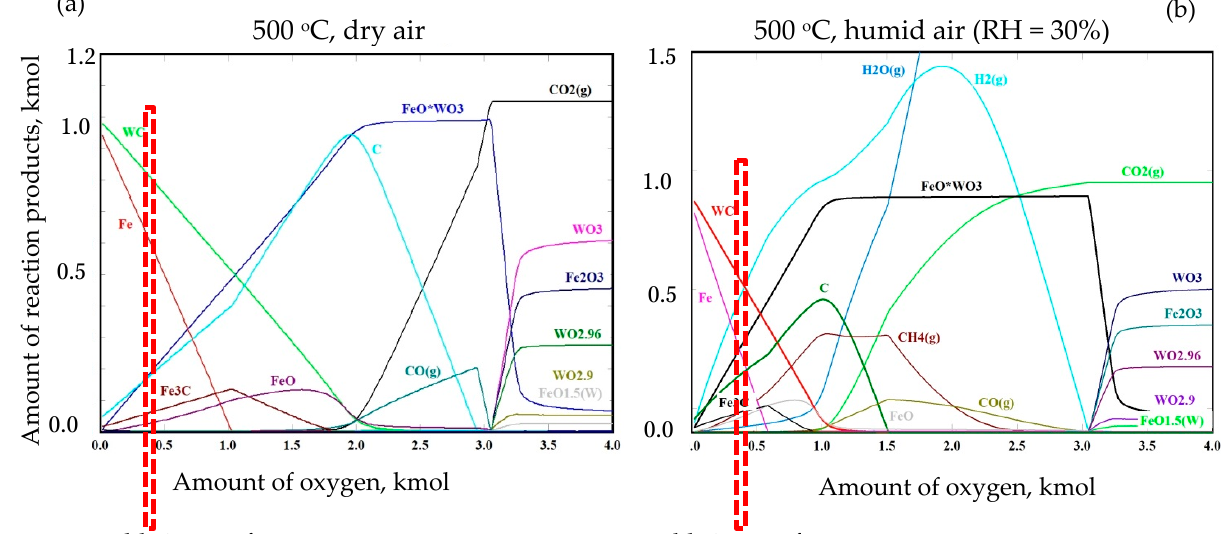
Figure 19. Modeling of the reaction products in WC + 5% C + Fe system at 500 °C as a function of the amount of oxygen in ( a ) dry air and ( b ) humid (RH = 30%) air [25–27] (reprinted with permission from Ref. [25], 2021, Elsevier). The composition corresponding to that of transfer layer would be obtained at around 0.25 kmol (indicated by a vertical frame).